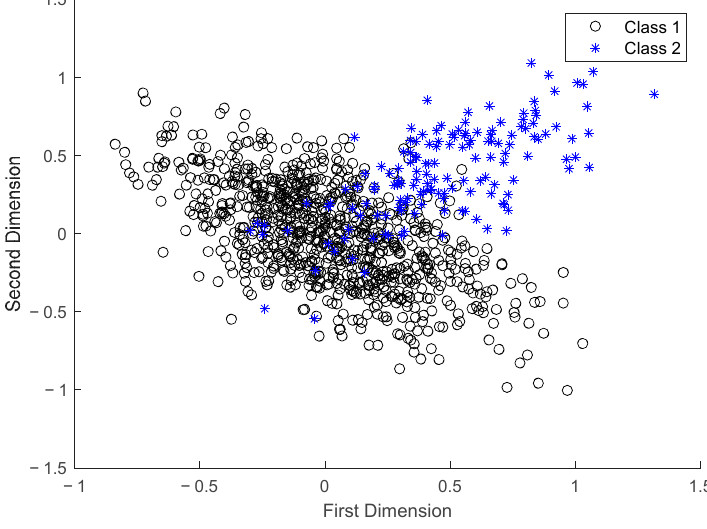
Figure 6. Process data classification diagram.